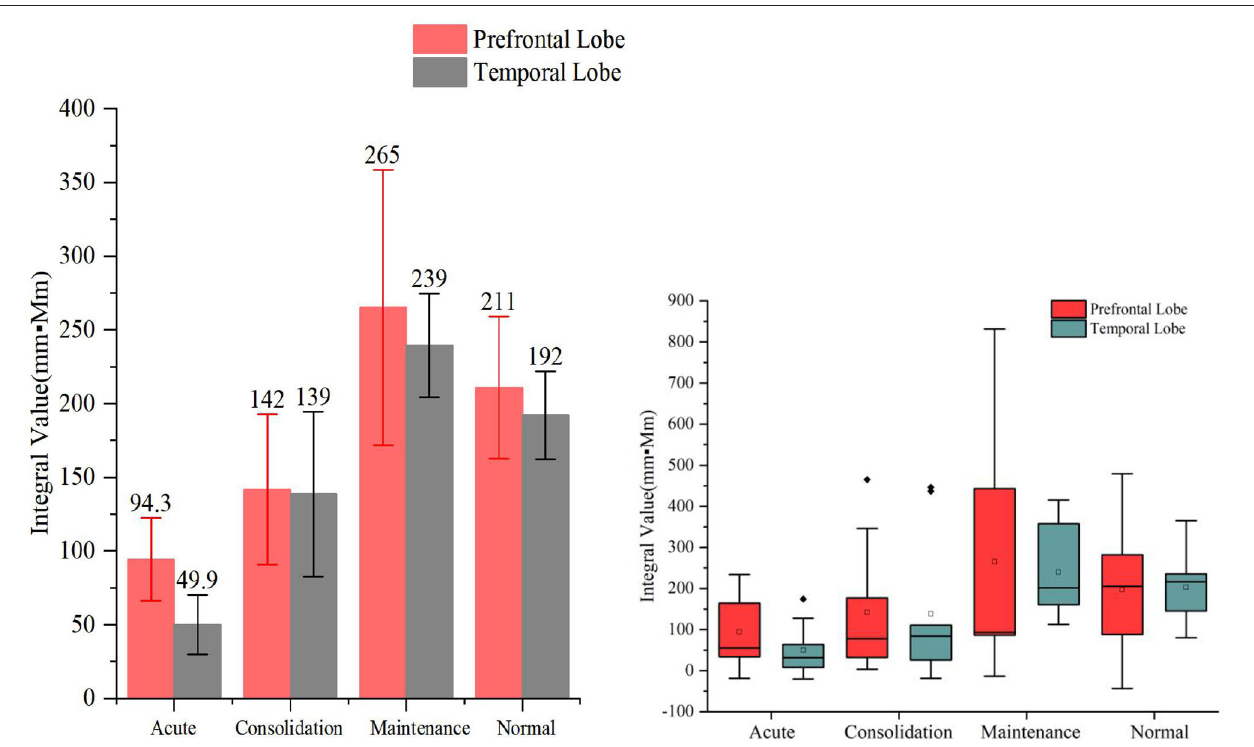
FIGURE 6 | The integral values (mean ± SD) of prefrontal and temporal lobe oxy-Hb from the anxiety and depression patients at the acute, consolidation, and maintenance stages as well as the healthy controls (HCs) under the high-level cognition task. The oxy-Hb integral values of both temporal lobes of the patients at the acute stages were significantly smaller than those of the HCs’ ( p <